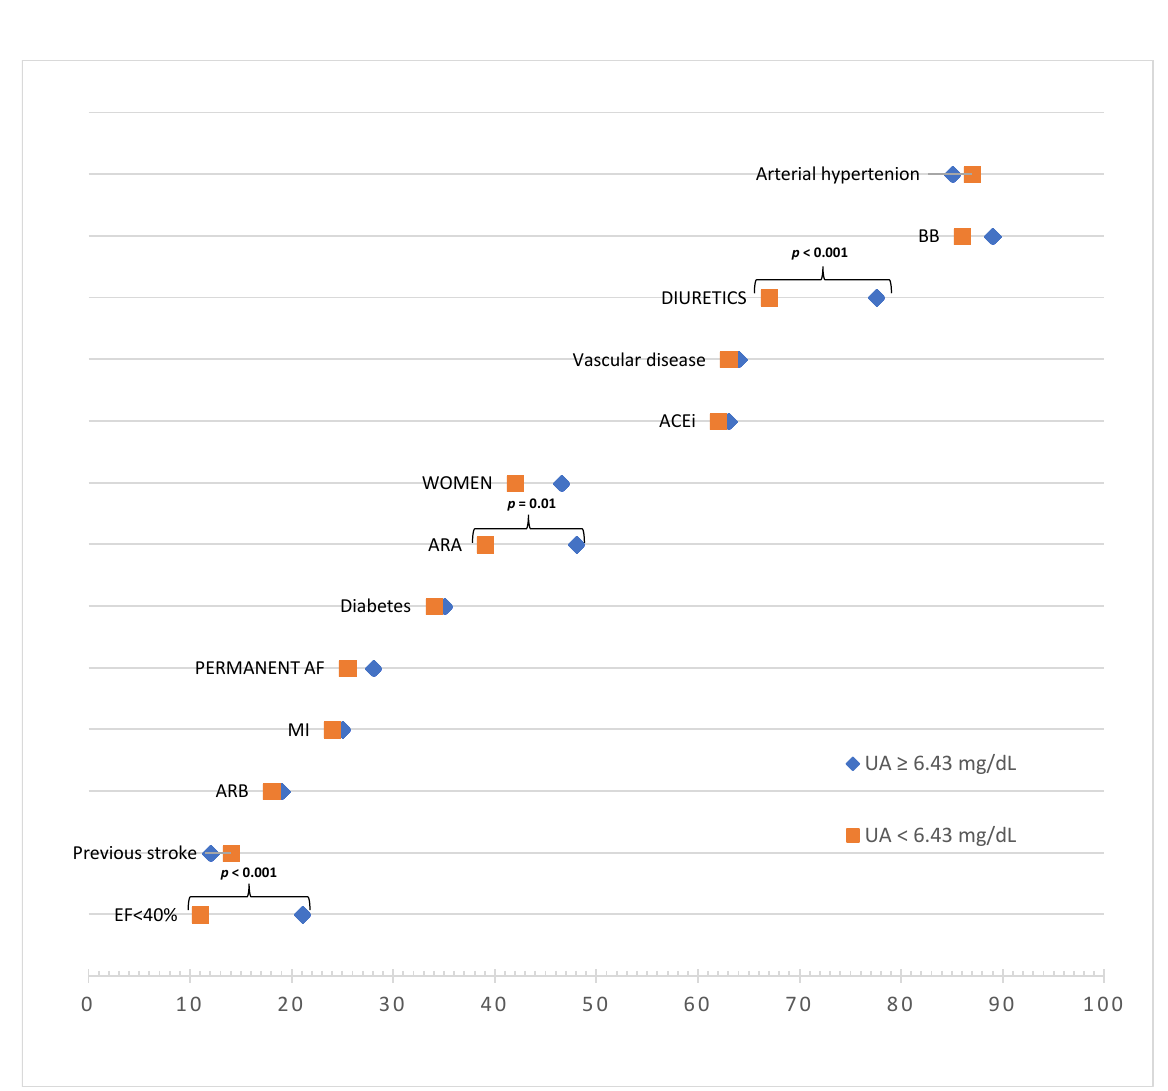
Figure 5. Comparison of groups, based on median UA concentration (6.43 mg/dL), as far as EF, diuretics usage and type of AF are concerned. Abbreviations: UA, uric acid; atrial fibrillation; EF, ejection fraction; ARA, aldosterone receptor antagonists; diuretics stands for: any and all diuretics, including ARA or/and loop diuretics.